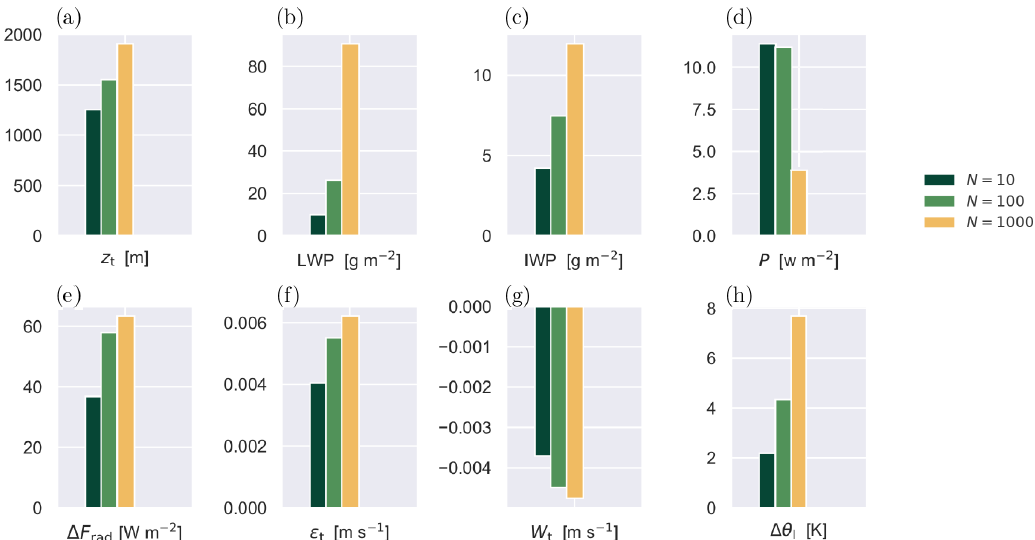
Figure 14. Bar plots of diurnally averaged bulk properties of the convective boundary layer, for all three CCN experiments as shown in Fig. 13. (a) Boundary layer depth z t . (b) LWP. (c) IWP. (d) Surface precipitation rate P . (e) Net longwave radiative flux divergence across the liquid cloud layer (cid:49)F rad . (f) Top entrainment rate (cid:15) t . (g) Large-scale vertical velocity at boundary layer top W t . (h) Jump in liquid water potential temperature (cid:49)θ l across the inversion. The time averaging covers the last 48h of the simulations.